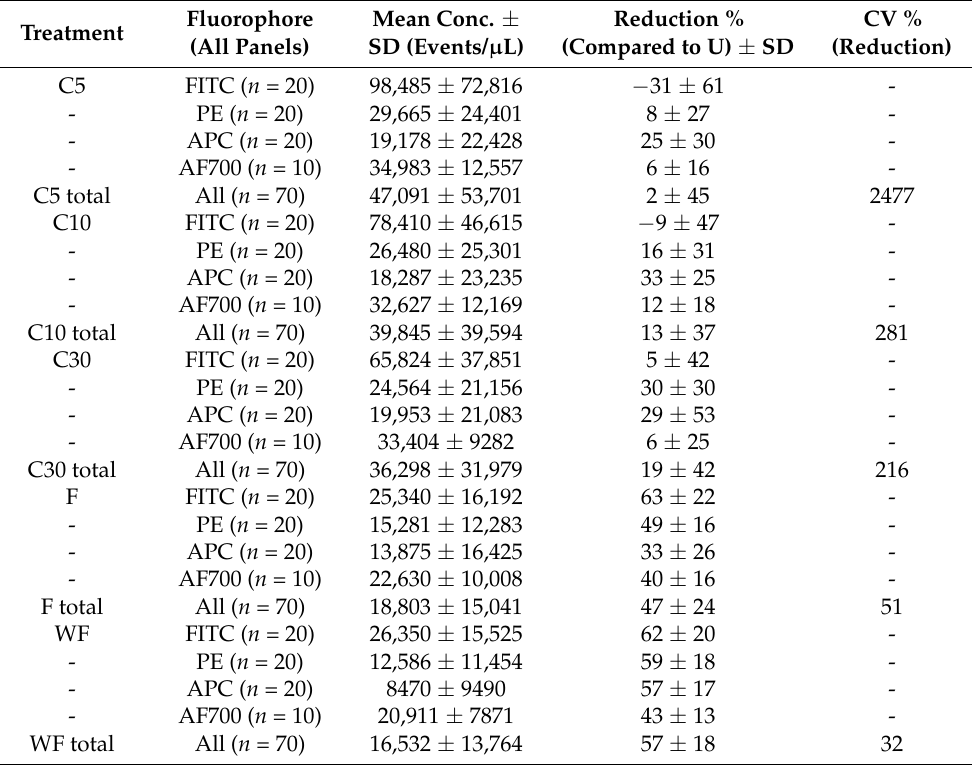
Table 4. Reduction (%) of mean event concentrations (evt/ µ L) of fluorophores in PBS labeled with panels treated with either 5, 10, or 30 min centrifugation (C5, C10, or C30) or filtered (F) or washed filter (WF), compared to evt/ µ L in PBS labeled with untreated labels (Table